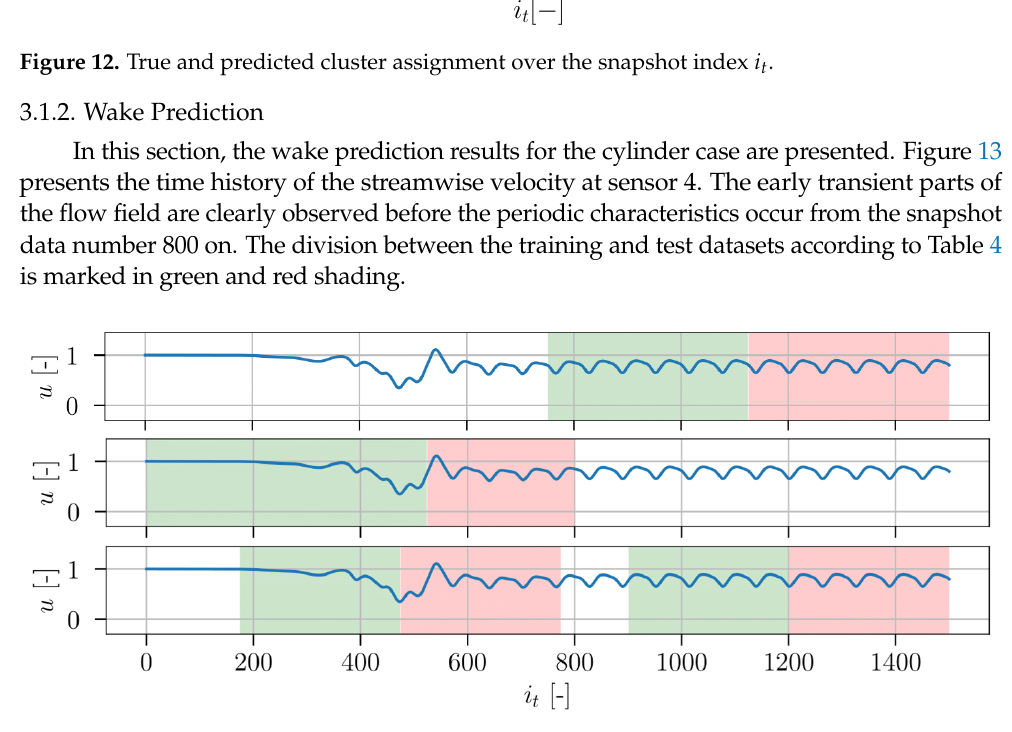
Figure 13. Velocity timeseries at sensor 4 and the considered time ranges. The time intervals from which data was used for training and test data are colored in green and red, respectively. Top: setup 1, middle: setup 2, bottom: setup 3, setup 4 and setup